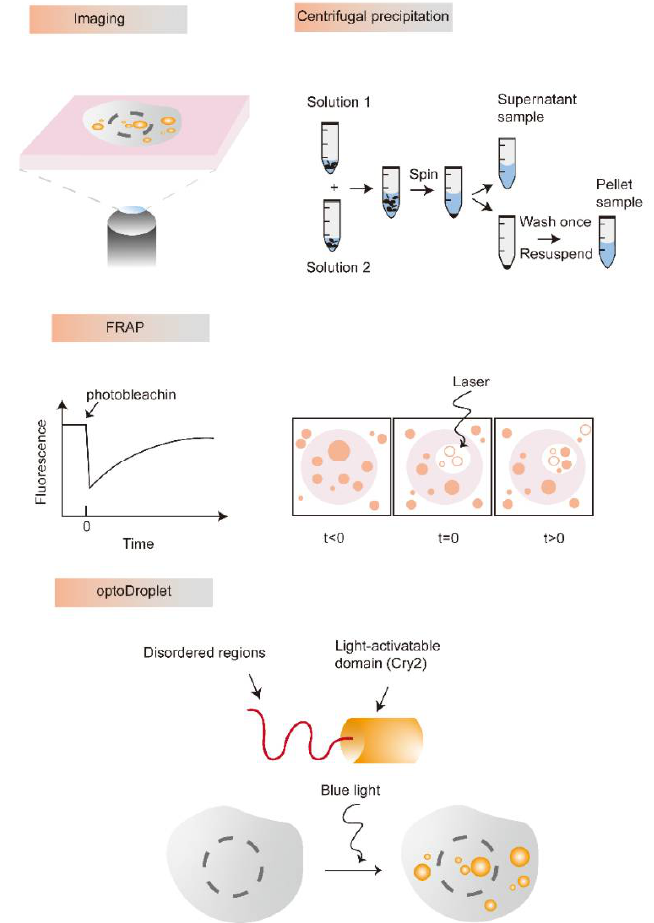
Figure 2. Representative research methods and technology to identify or study LLPS. Various microscopic techniques can be used to detect the process of phase transition and visualize the properties of droplets. Centrifugal precipitation is another common detection strategy of LLPS. The FRAP is the well-recognized method for the observation of LLPS, which was accomplished by measuring the fluorescence intensity of the bleached region prior to, immediately after, and throughout recovery from bleaching. The optoDroplet provides a level of control that we can use to precisely map the phase diagram in living